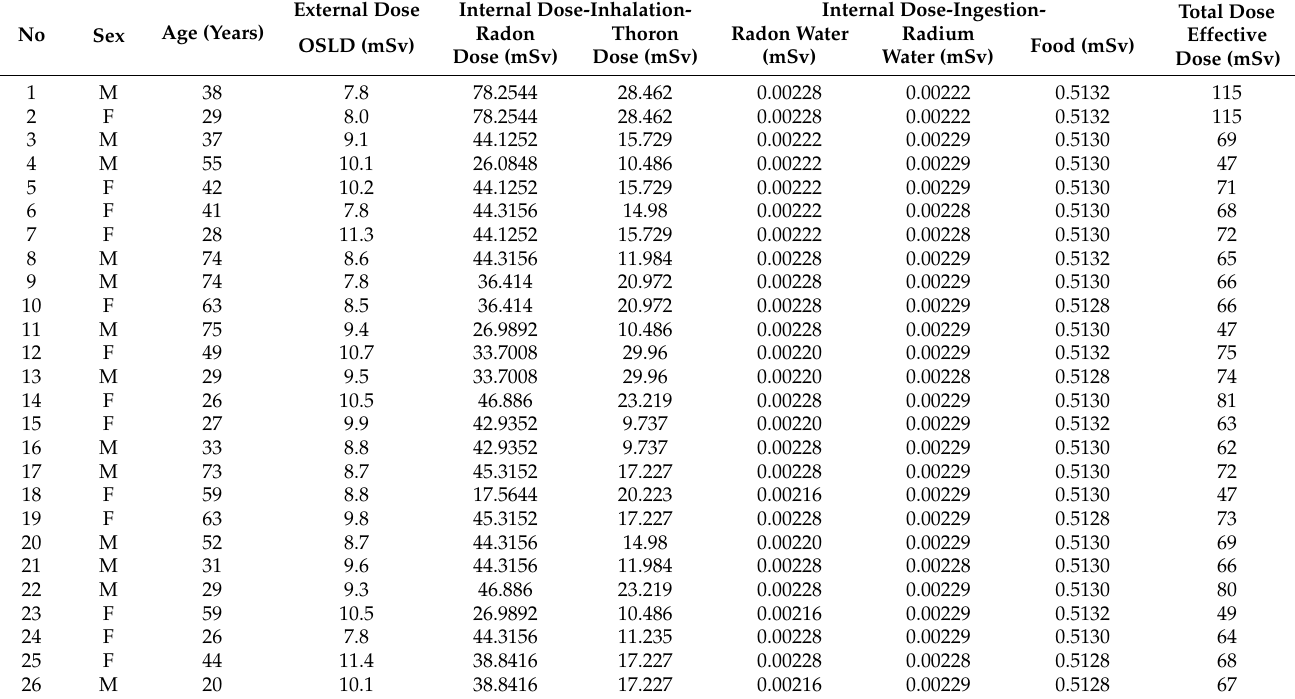
Table 2. Estimated annual effective dose of study subjects living in